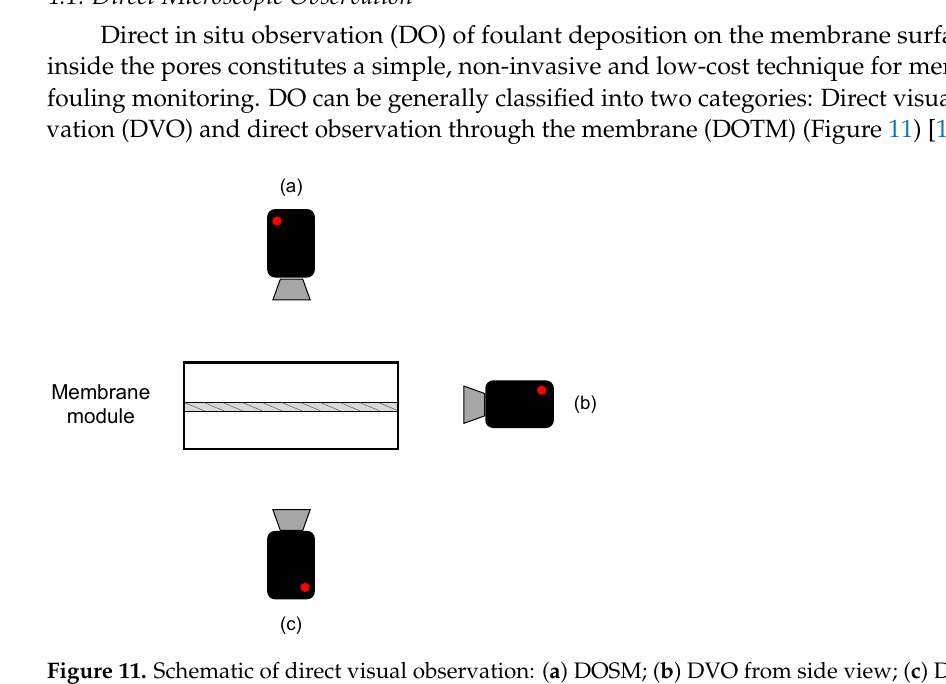
Figure 11. Schematic of direct visual observation: ( a ) DOSM; ( b ) DVO from side view; ( c ) DOTM.